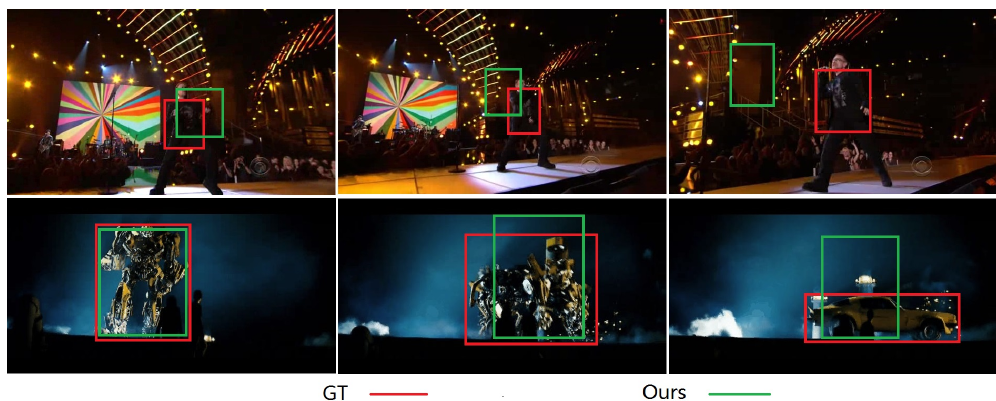
Figure 5. Failure case analysis. The red and green bounding boxes are the ground truth and results of the proposed method,